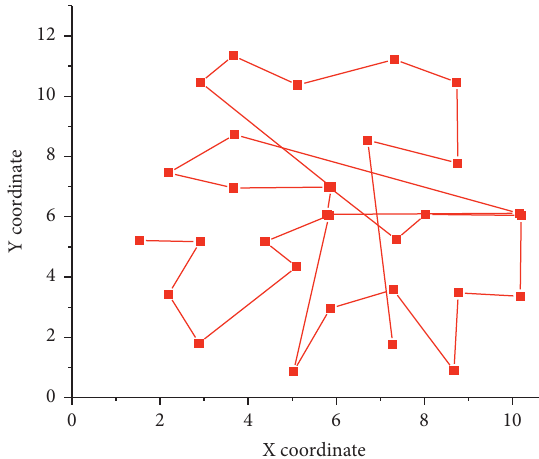
Figure 16: Optimal scheduling path based on digital